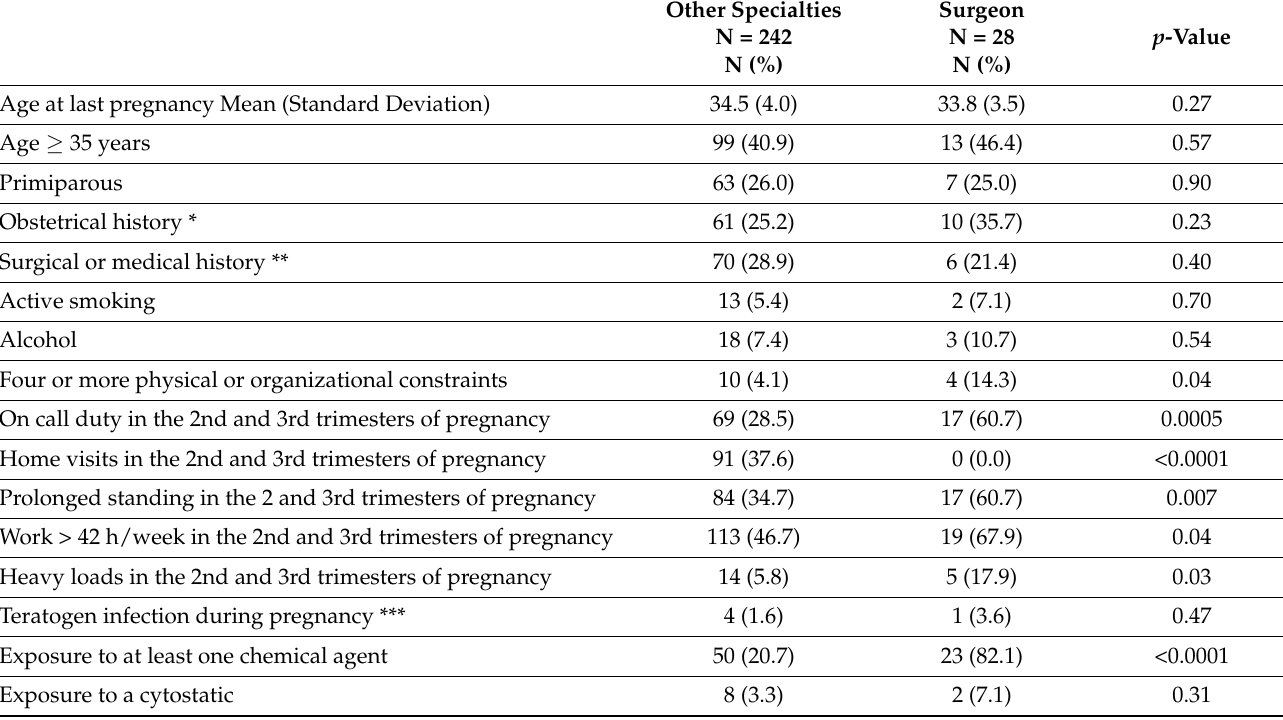
Table 2. Pregnancy complications among 270 female physicians.